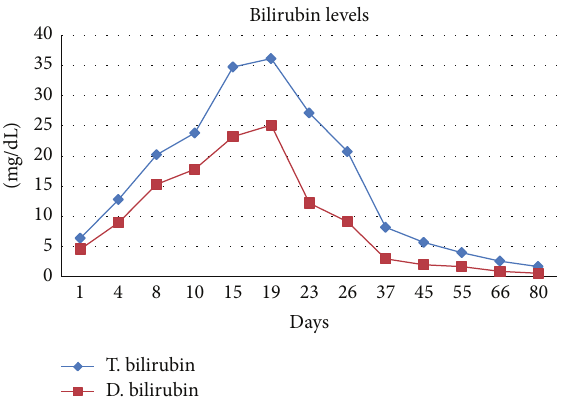
Figure 3: Changings of bilirubin